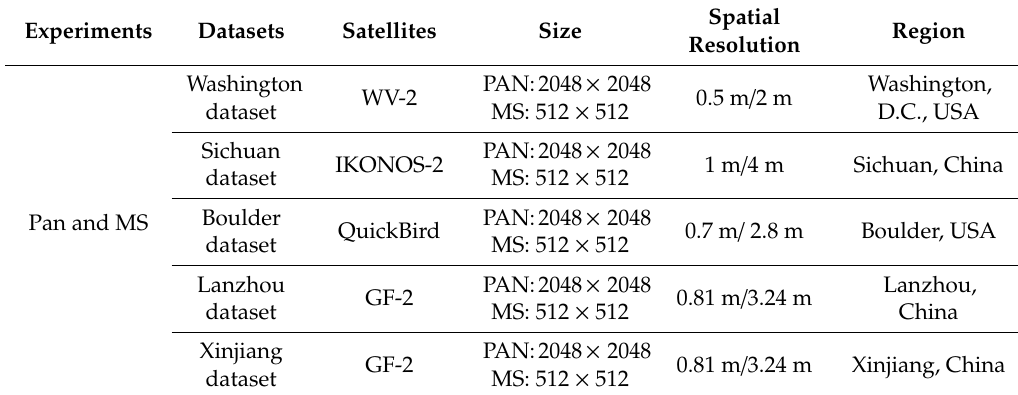
Table 1. Datasets for experiments.